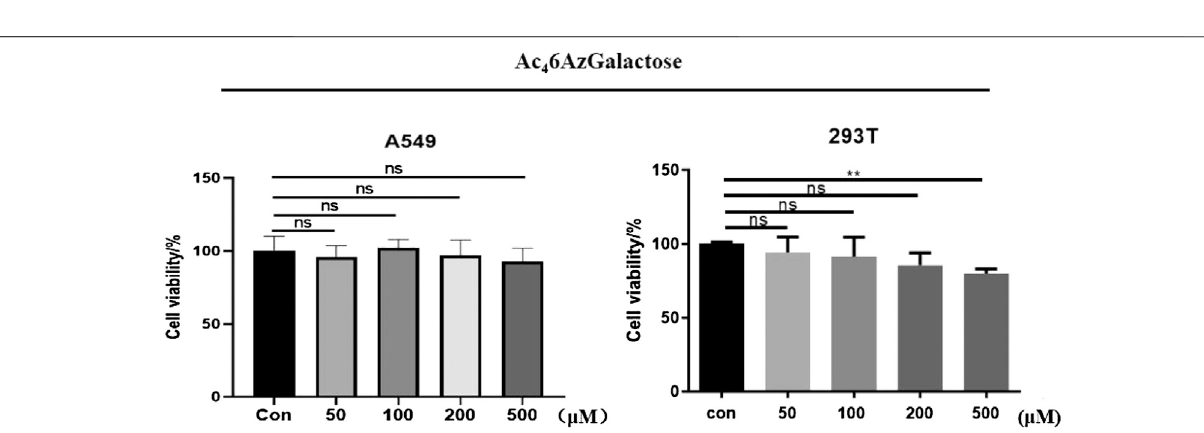
(A) or with 200 μ M Ac (B) , followed by 4 6AzGal for 16 h 4 6AzGal for the indicated times